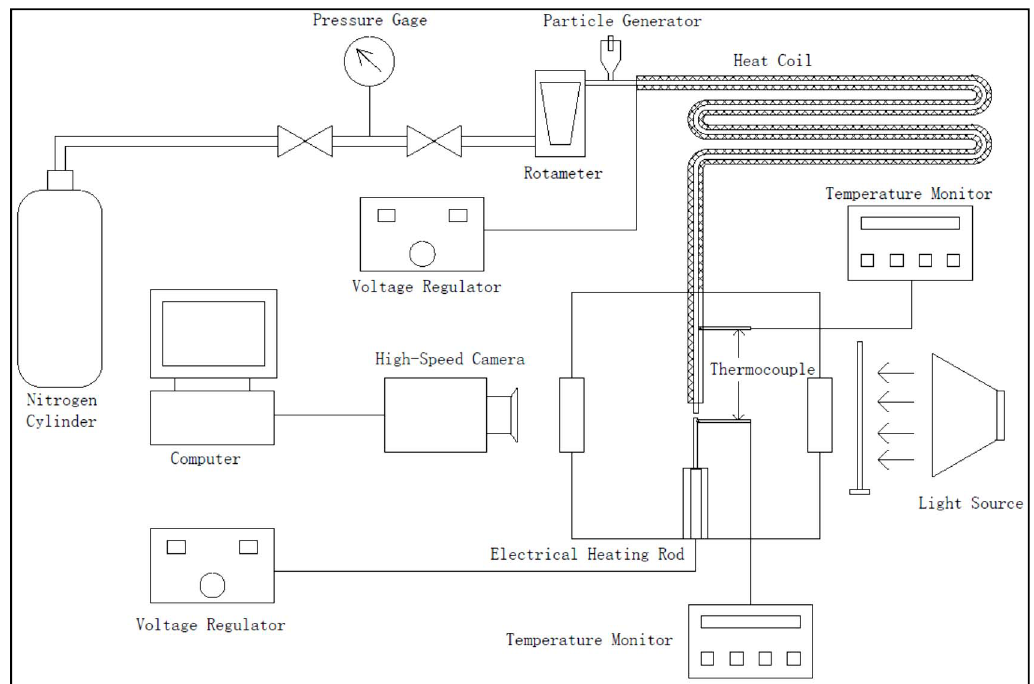
Figure 1. Schematic of the experimental configuration with the high-speed camera system used in the normal impact experiments.